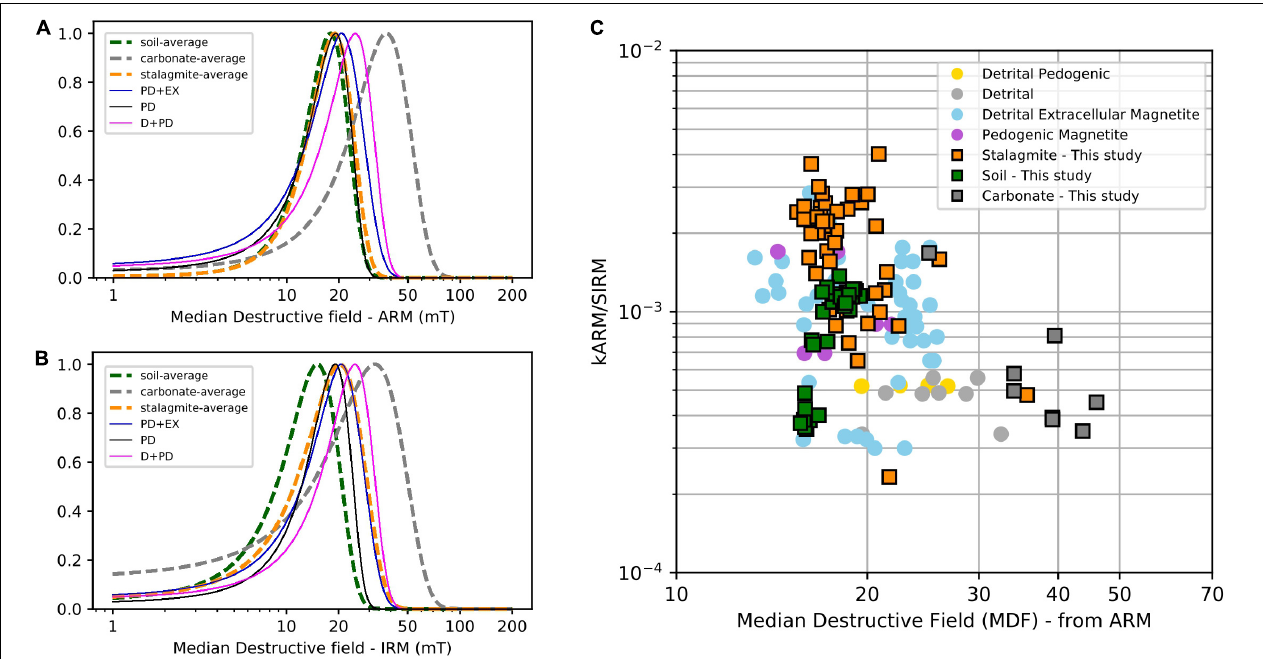
FIGURE 7 | (A) Average coercivity distribution of anhysteretic remanent magnetization (ARM) and (B) isothermal remanent magnetization (IRM) of stalagmite (dashed orange), soil (dashed green), and carbonate (dashed gray) obtained from skewed generalized Gaussian (SGG) function (Max UnMix). Reference values of pedogenic + extracellular magnetite (PD + EX) (blue), pedogenic (PD) (black), and detrital + pedogenic (pink) retrieved from the average values of ARM analysis by Egli (2004b). (C) Biplot of K ARM /IRM and median destructive field (MDF) of ARM from stalagmites (orange squares), soil (green squares), and carbonate (gray squares). Magnetic properties taken from Egli (2004b) represent detrital pedogenic (yellow), detrital (light gray circles), detrital extracellular magnetite (light blue circles), and pedogenic magnetite (purple